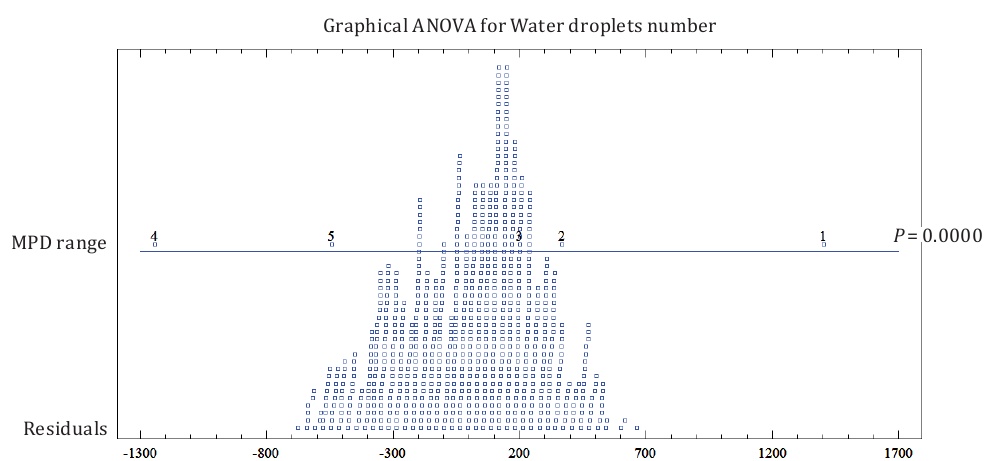
Figure 20. Graphical ANOVA plot for water